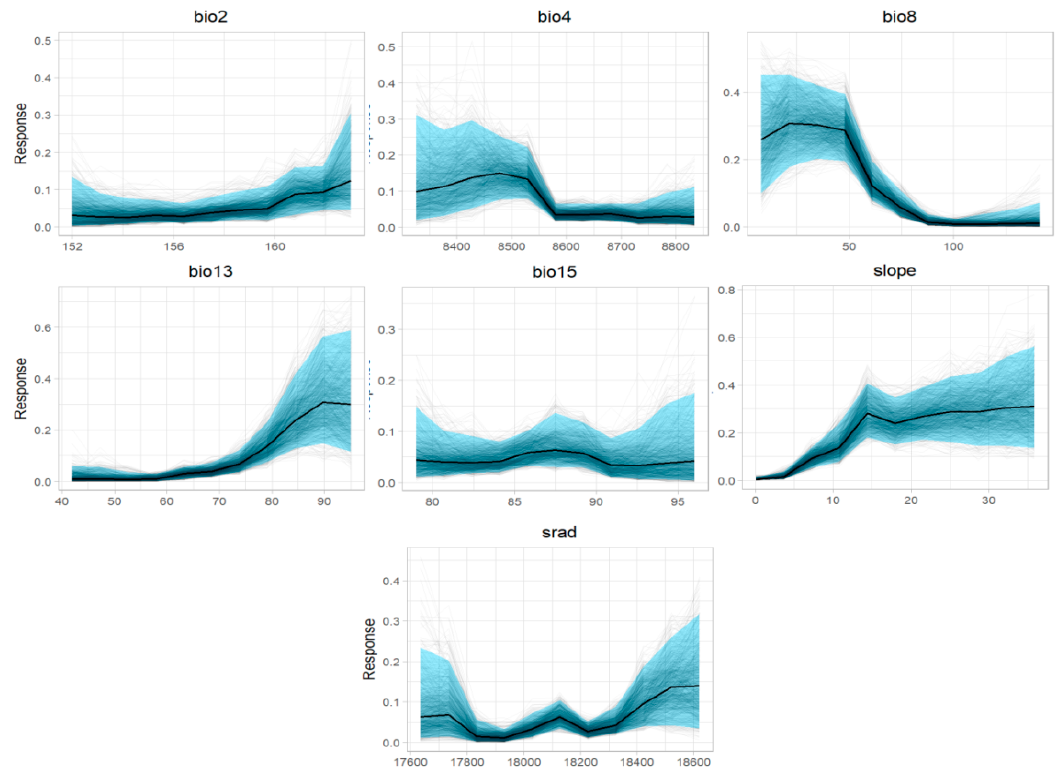
Figure 5. Response curves of Quercus brantii to environmental variables.